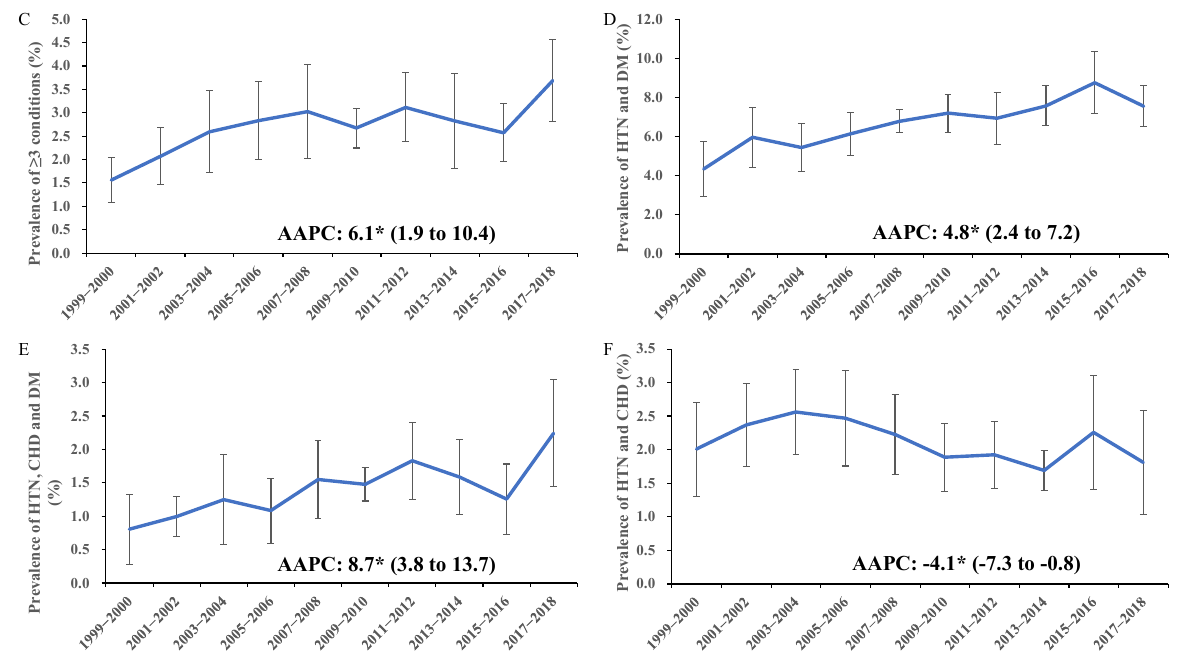
Figure 1. Trends in the age-adjusted prevalence of cardiometabolic multimorbidity and specific pat- terns among U.S. adults, 1999–2018. Notes: The AAPC was derived from joinpoint regression models to assess the averaged trends in the prevalence of comorbidity. Panel A: For CMM overall; Panel B: For two concurrent cardiometabolic diseases; Panel C: For ≥ three concurrent cardiometabolic dis- eases; Panel D: For CMM pattern, HTN, and DM; Panel E: For CMM pattern, HTN, CHD, and DM; Panel F: For CMM pattern, HTN, and CHD. CMM, cardiometabolic multimorbidity; HTN, hyper- tension; DM, diabetes mellitus; CHD, coronary heart disease; AAPC, averaged two-year cycle per- centage change. * p for trend <0.05.